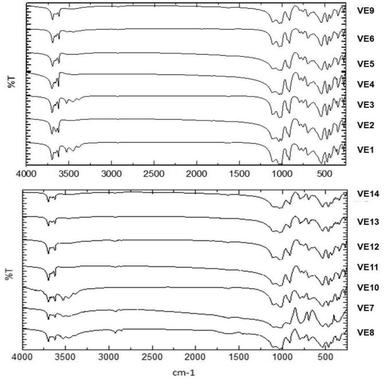
FTIR spectra of the studied samples.